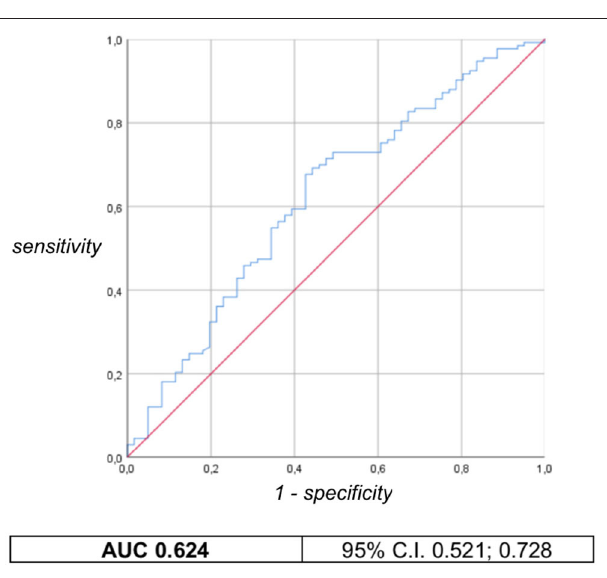
FIGURE 2 | Longitudinal post-loss definition of EUGR for HC: ROC curve and AUC with 95% confident